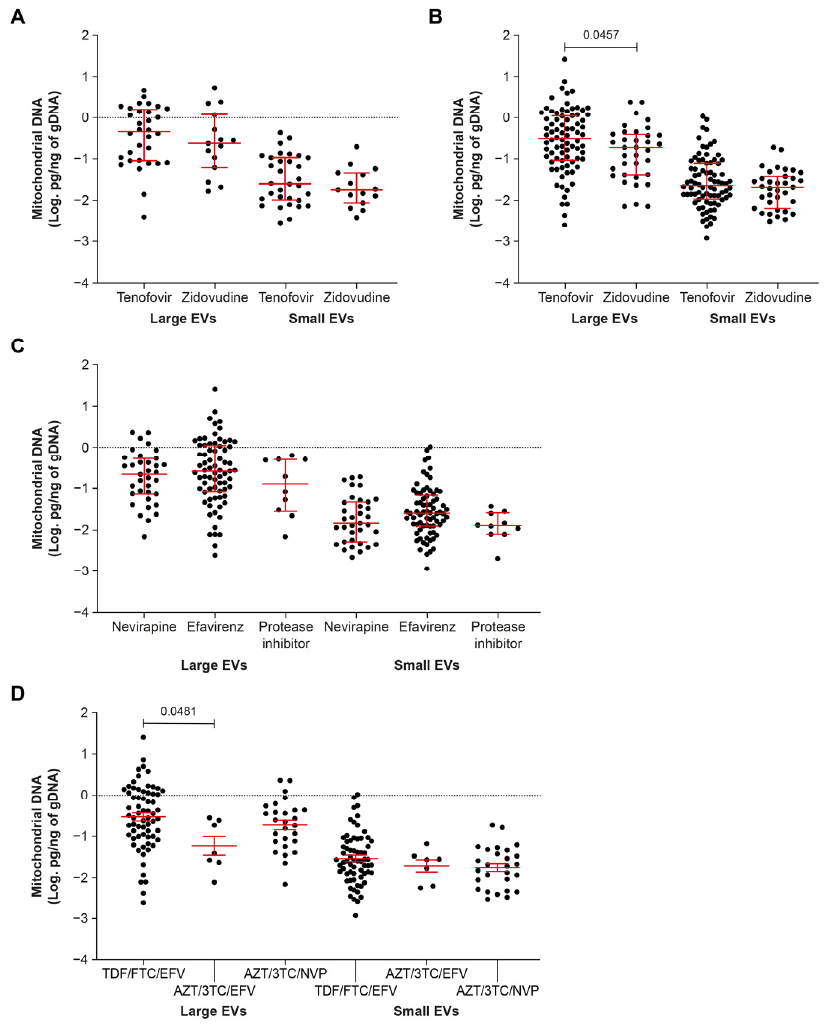
Figure 2. Mitochondrial DNA in large and small EVs in viremic ( A ) and aviremic ( B ) patients on antiretroviral therapy including Zidovudine or Tenofovir for more than six months; in aviremic patients receiving Nevirapine, Efavirenz, or protease inhibitors ( C ); or a combination of Tenofovir/Emtricitabine/Efavirenz (TDF/FTC/EFV), Zidovudine/lamivudine/Efavirenz (AZT/3TC/EFV), or Zidovudine/lamivudine/Nevirapine (AZT/3TC/NVP) ( D ). In graphs, the dots represent individual value and lines the geometric mean with geometric standard deviation factor. Group comparisons are based on t -tests and ordinary one-way ANOVA with Tukey’s multiple comparisons